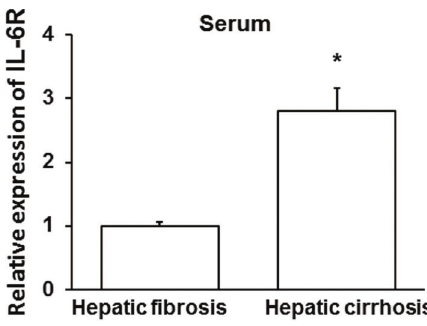
Figure 3. ELISA analysis of IL-6R protein expression in serum from hepatitis B patients with liver fi brosis and liver cirrhosis. Data are reported as means ± SD. *P o 0.05, ANOVA.